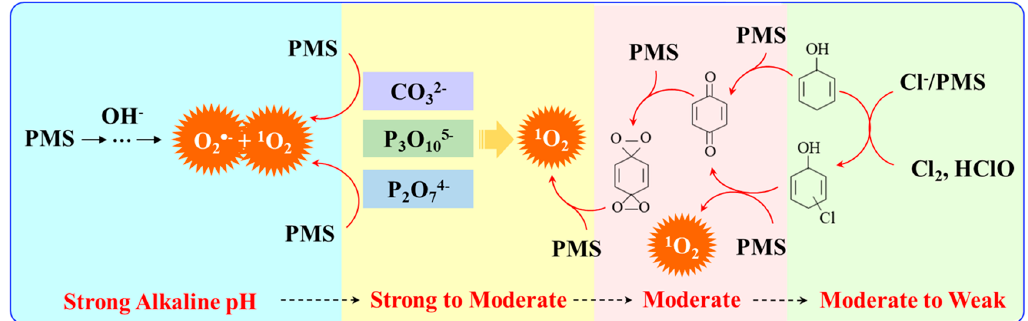
Figure 1. ( a ) Reported pathways of 1 O 2 evolution; ( b ) the quenching effect of 1 O 2 on phenol degra- dation with β - MnO 2 (data reorganized from [19]); ( c ) EPR characteristic spectrum of TEMP- 1 O 2 (figure reprinted from [31]). The EPR spectrometer settings were as follows: modulation fre- quency, 100 kHz; modulation width, 0.079 mT; scanning field, 335 ± 10 mT; amplitude: 2–500; time constant, 0.1–0.3 s; sweep time, 4 min; microwave power, 4 mW; and microwave frequency, 9.41 GHz.; ( d ) oxidation pathways of some emerging contaminants by 1 O 2 [8,34,38], reprinted with per- mission from Elsevier.